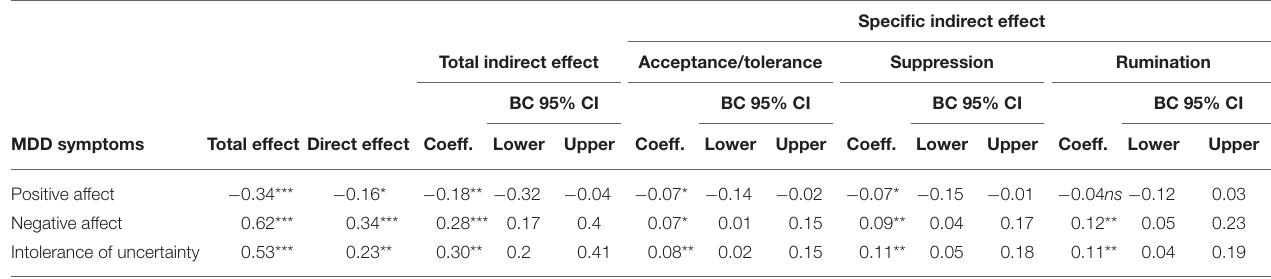
TABLE 5 | Mediation of the effect of affectivity and intolerance of uncertainty on depressive disorder symptoms (RCADS-30-MDD) through emotion regulation strategies (acceptance/tolerance, suppression, and rumination) (fully standardized regression coefficients).